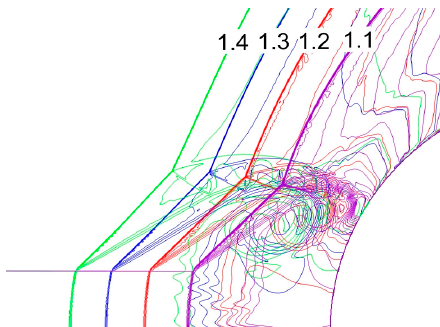
Figure 5. Dependence of the angles in triple-shock configuration on γ (overlay of four flow images with γ = 1.1, γ = 1.2, γ = 1.3, and γ = 1.4).